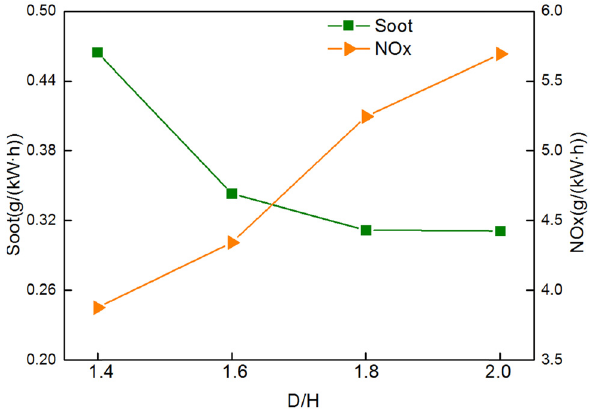
Figure 18: Soot and NOx emissions under di ff erent diameter - to - depth